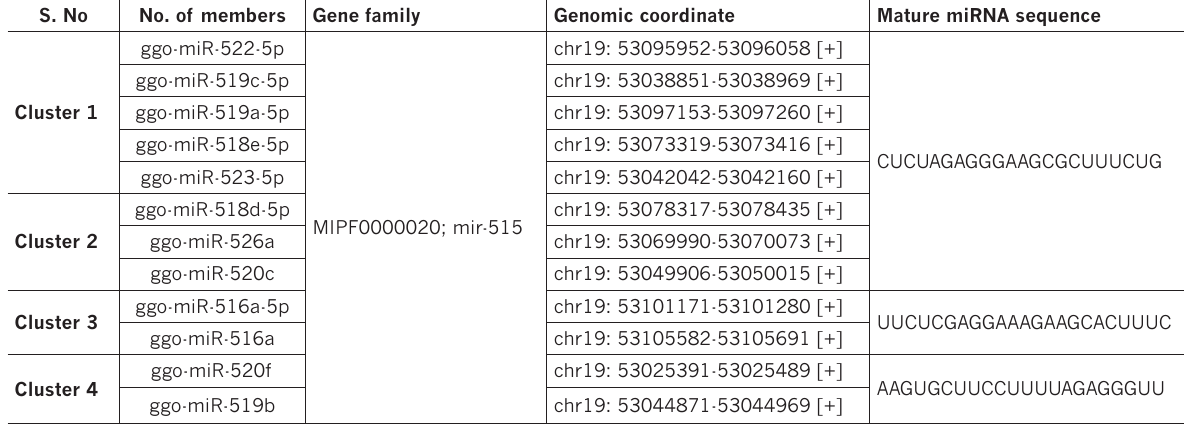
Table 2. List of miRNAs grouped into clusters, their genomic coordinates, gene family names and their matured miRNA sequences in Gorilla gorilla .